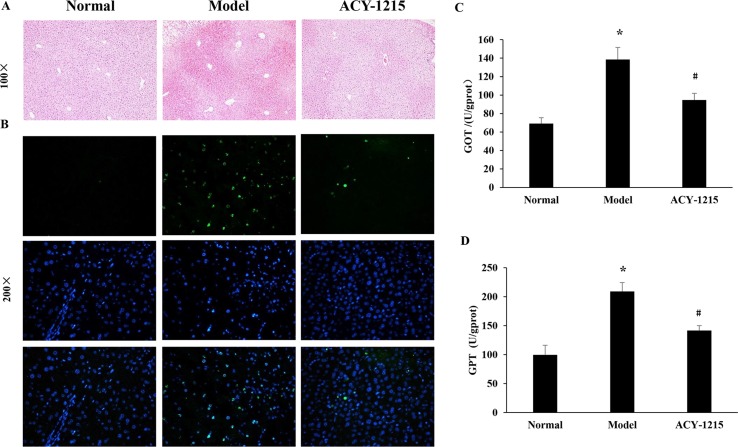
The effect of ACY-1215 treatment of the necrosis of hepatocytes and the impaired liver function in ALF mice. (A) The results of the hematoxylin and eosin (HE) staining (original magnification ×100) showed that ACY-1215 could alleviate necrotic changes and preserve the architecture of liver. (B) The results of terminal deoxynucleotidyl transferase (TdT)-mediated 2'-Deoxyuridine 5'-Triphosphate (dUTP) Nick-End Labeling (TUNEL) showed the effect of ACY-1215 on the necrosis of hepatocytes. (C) Treatment with ACY-1215 normalized the activities of glutamic oxaloacetic transaminase (GOT). (D) Treatment with ACY-1215 normalized the activities of glutamate pyruvic transaminase (GPT). *P < 0.05 as compared with the corresponding normal group. #
P < 0.05 vs model group.